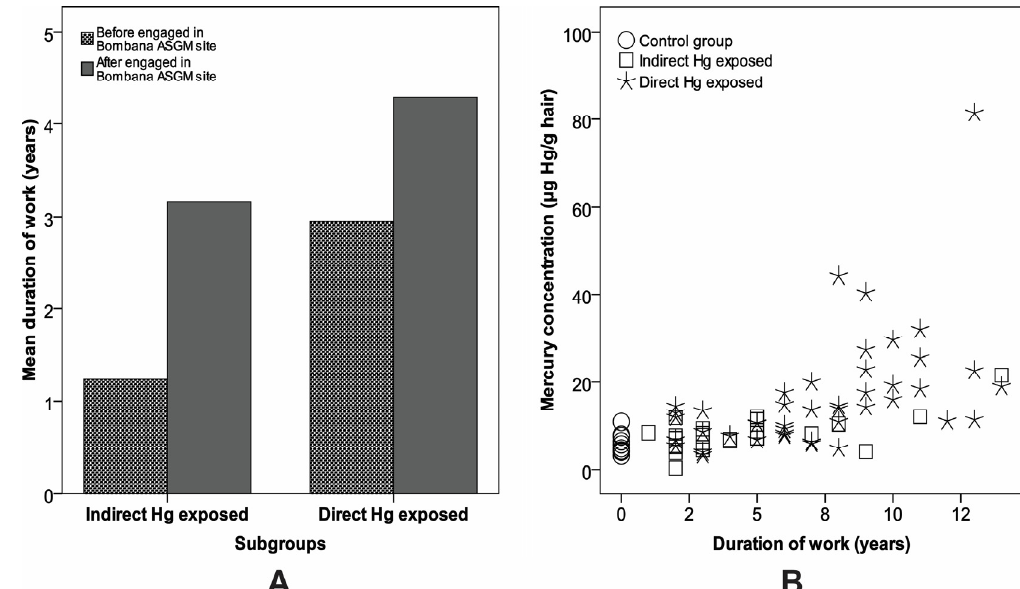
Figure 4. Duration of work. ( A ) Direct and indirect Hg-exposed have different mean duration of work base time involved with the Bombana ASGM site. ( B ) Duration of work has a positive correlation to mercury concentration for each group.